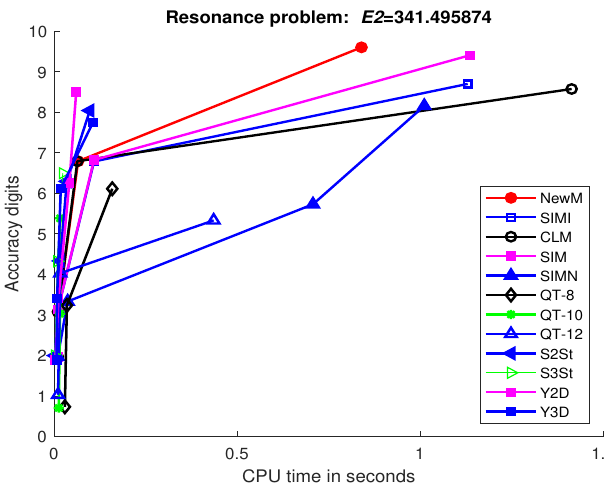
Figure 6. Efficiency of the compared methods for E 2 = 341.495874.